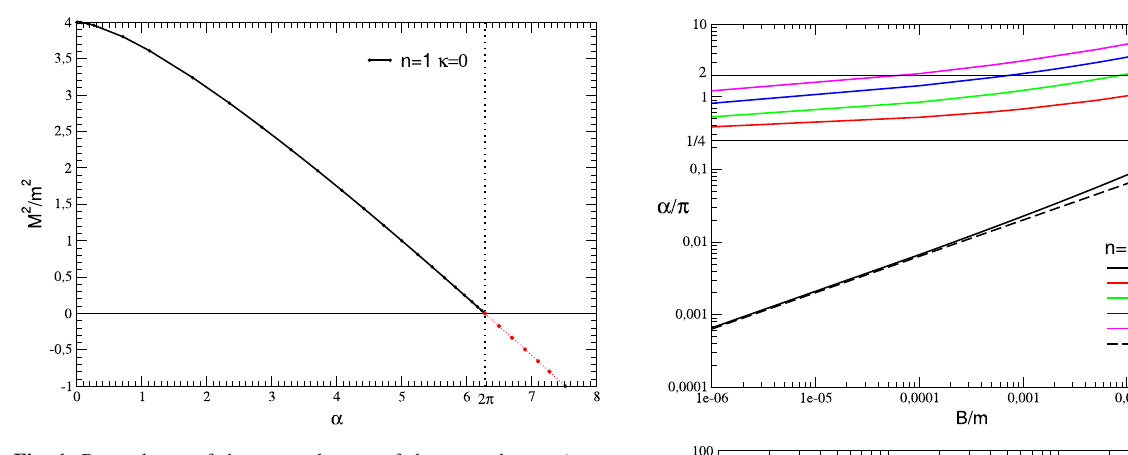
Fig. 1 Dependence of the squared mass of the ground state ( n = 1 ,κ = 0 ) on the coupling constant α . Beyond the criticalvalue α = 2 π , the solutions are smootly continued without any singularity but hav- ing negative values of M 2 . The physical region, where the system has well-defined ground state mass and binding energy, is thus limited to α ∈ [ 0 , 2 π ]